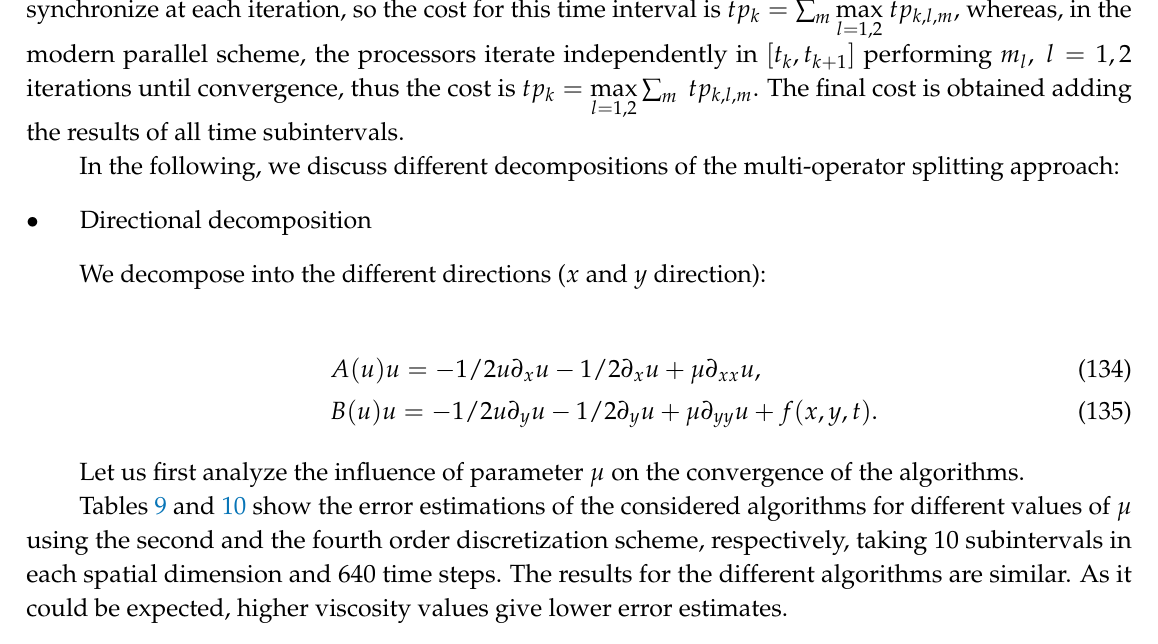
Table 9. Mixed convection-diffusion and Burgers’ equation. Results of the directional decomposition using the second order scheme for the spatial discretization, with 10 spatial subintervals, 640 temporal intervals and different values of µ